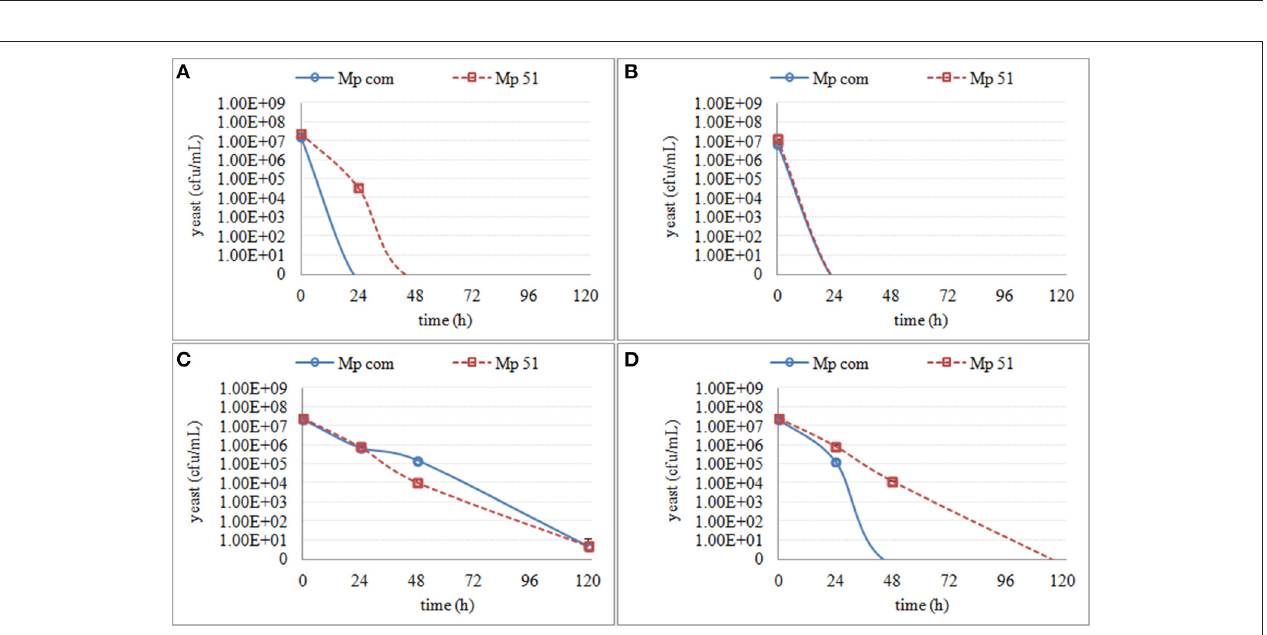
FIGURE 3 | The culturable population of three H. uvarum strains (CECT13130, NSb and CECT1444) grown in different synthetic media for 120h. (A) the growth in supernatant from the second stage of S. cerevisiae fermentation S-2 (B) the growth in supernatant from the third stage of S. cerevisiae fermentation S-3 (C) the growth in synthetic media MS-3 (D) the growth in synthetic media MM-3.